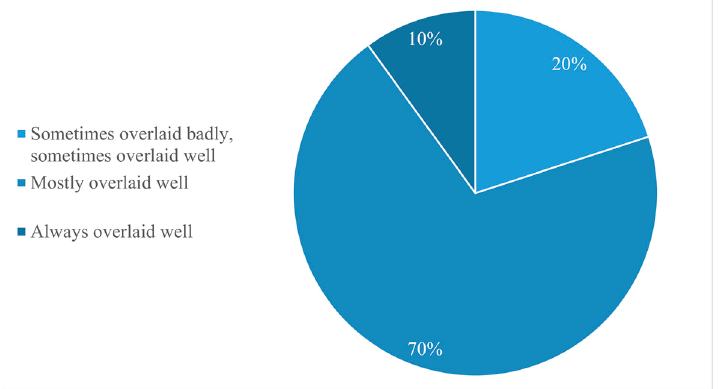
Figure 19. Answers to the question “How well did the graphics overlay the real-world objects?”.